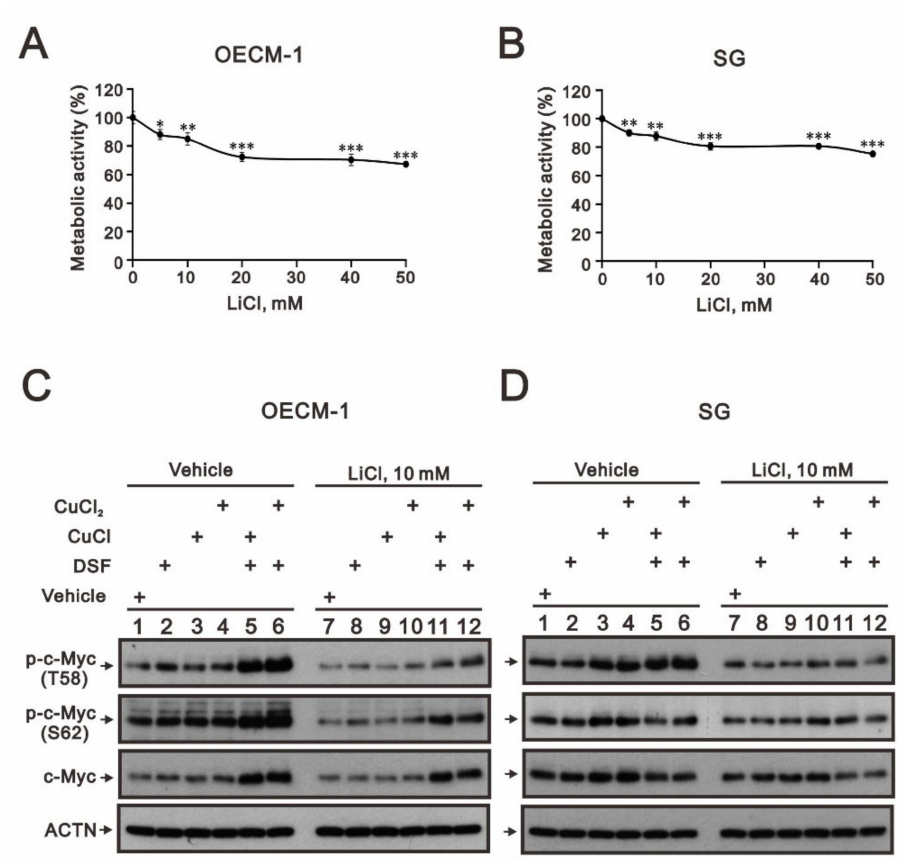
Figure 5. The effects of LiCl on the c-Myc proteins in DSF/copper-complex-treated OECM-1 and SG cells. ( A ) OECM-1 and ( B ) SG cells were treated with 0, 5, 10, 20, 40, and 50 mM LiCl for 24 h. The metabolic activity was measured using MTT assays. * p < 0.05, ** p < 0.01, and *** p < 0.001. ( C ) OECM-1 and ( D ) SG cells were pretreated with 10 mM LiCl for 1 h and then treated with 50 µ M of CuCl 2 plus 0.5 µ M of DSF or 2 µ M of CuCl plus 0.5 µ M of DSF for 2 h (added indicated drugs labeled with +). The cell lysates were subjected to Western blot analysis using antibodies against the indicated proteins. ACTN was a loading protein